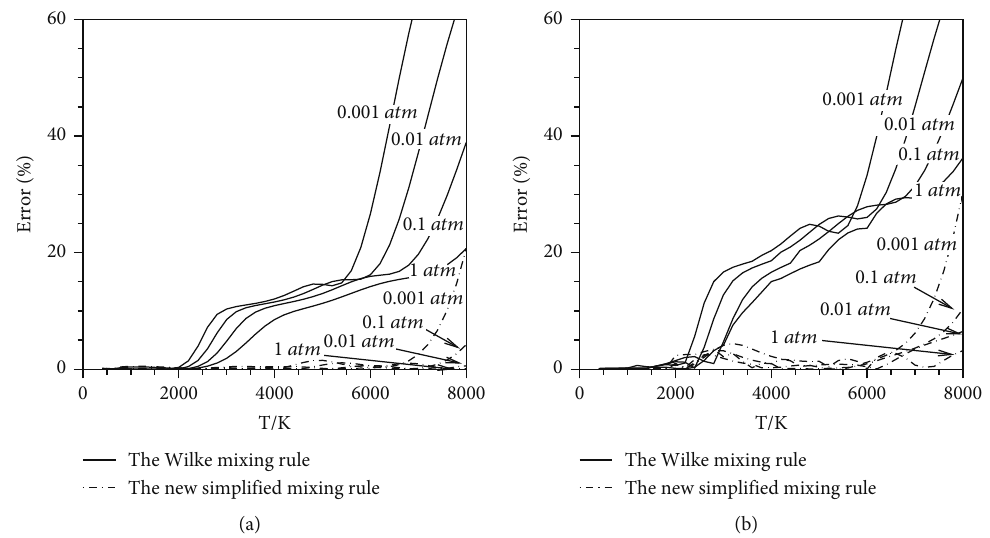
Figure 15: The deviation between the mixing rules (the Wilke mixing rule and the new simpli fi ed mixing rule) and the CE method. (a) Viscosity; (b) translational thermal